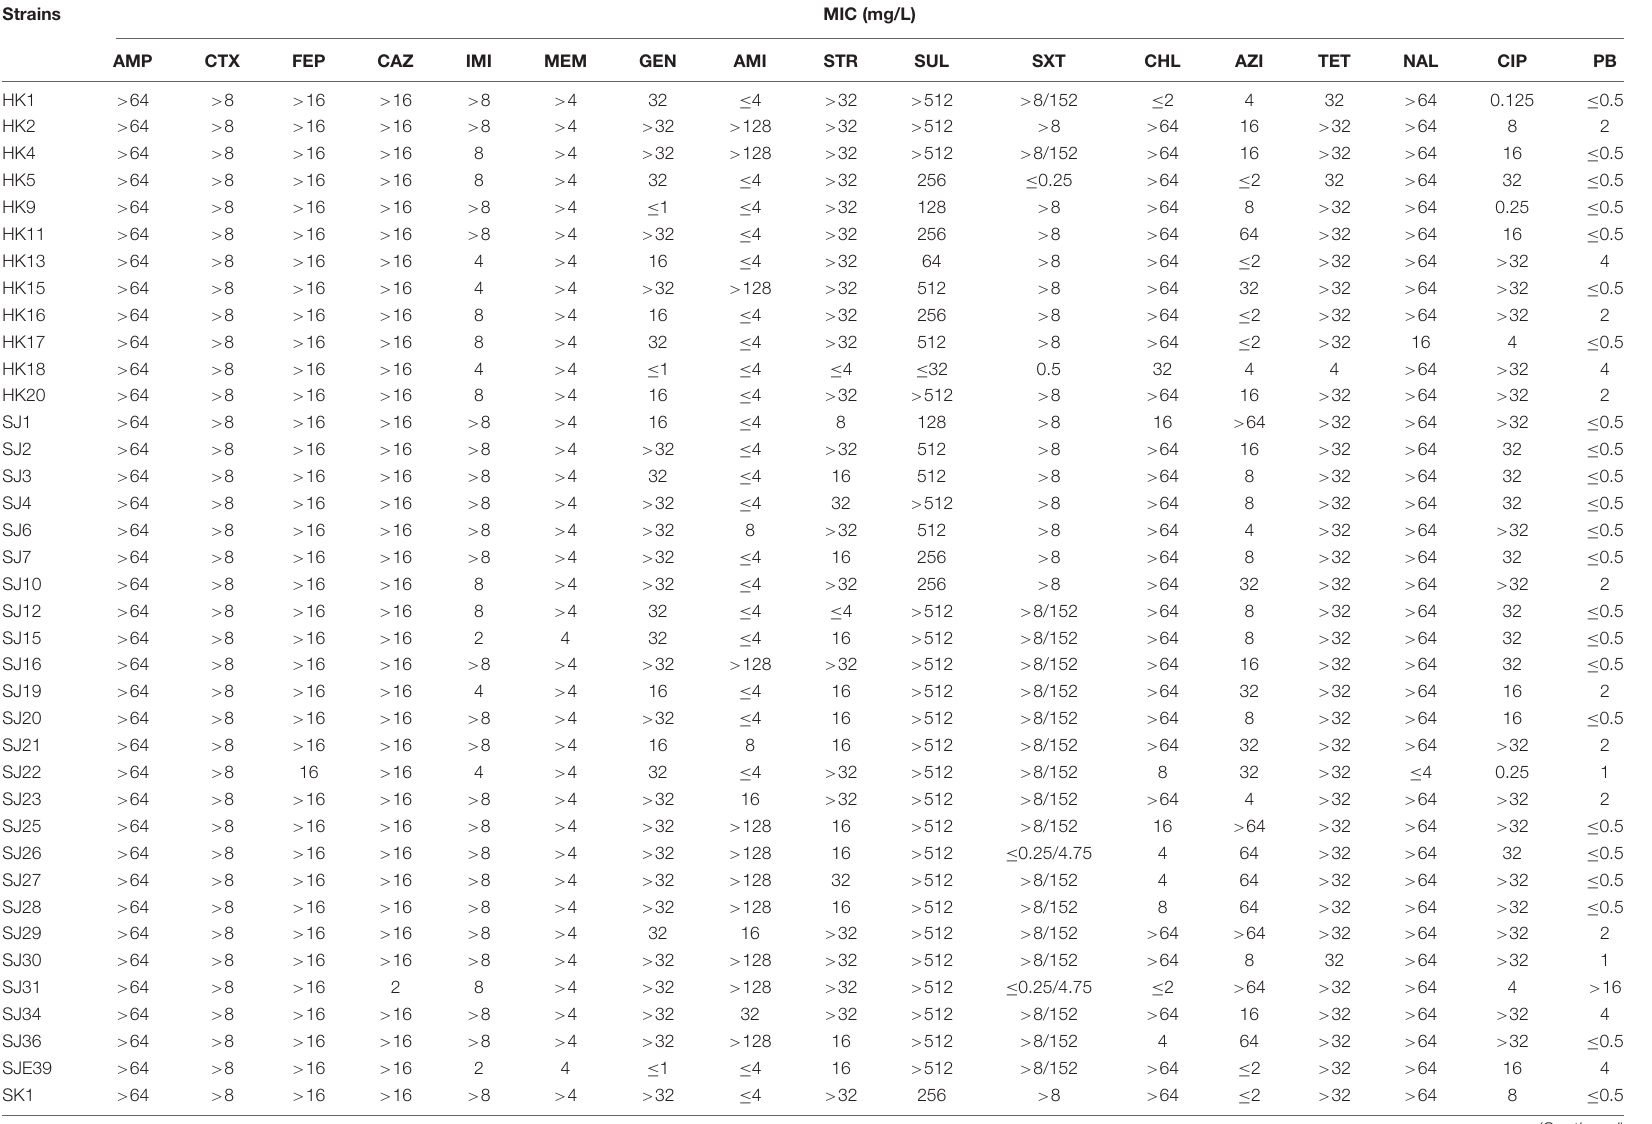
TABLE 1 | Minimal inhibitory concentration results of 17 antibiotics of all the isolates in this study.